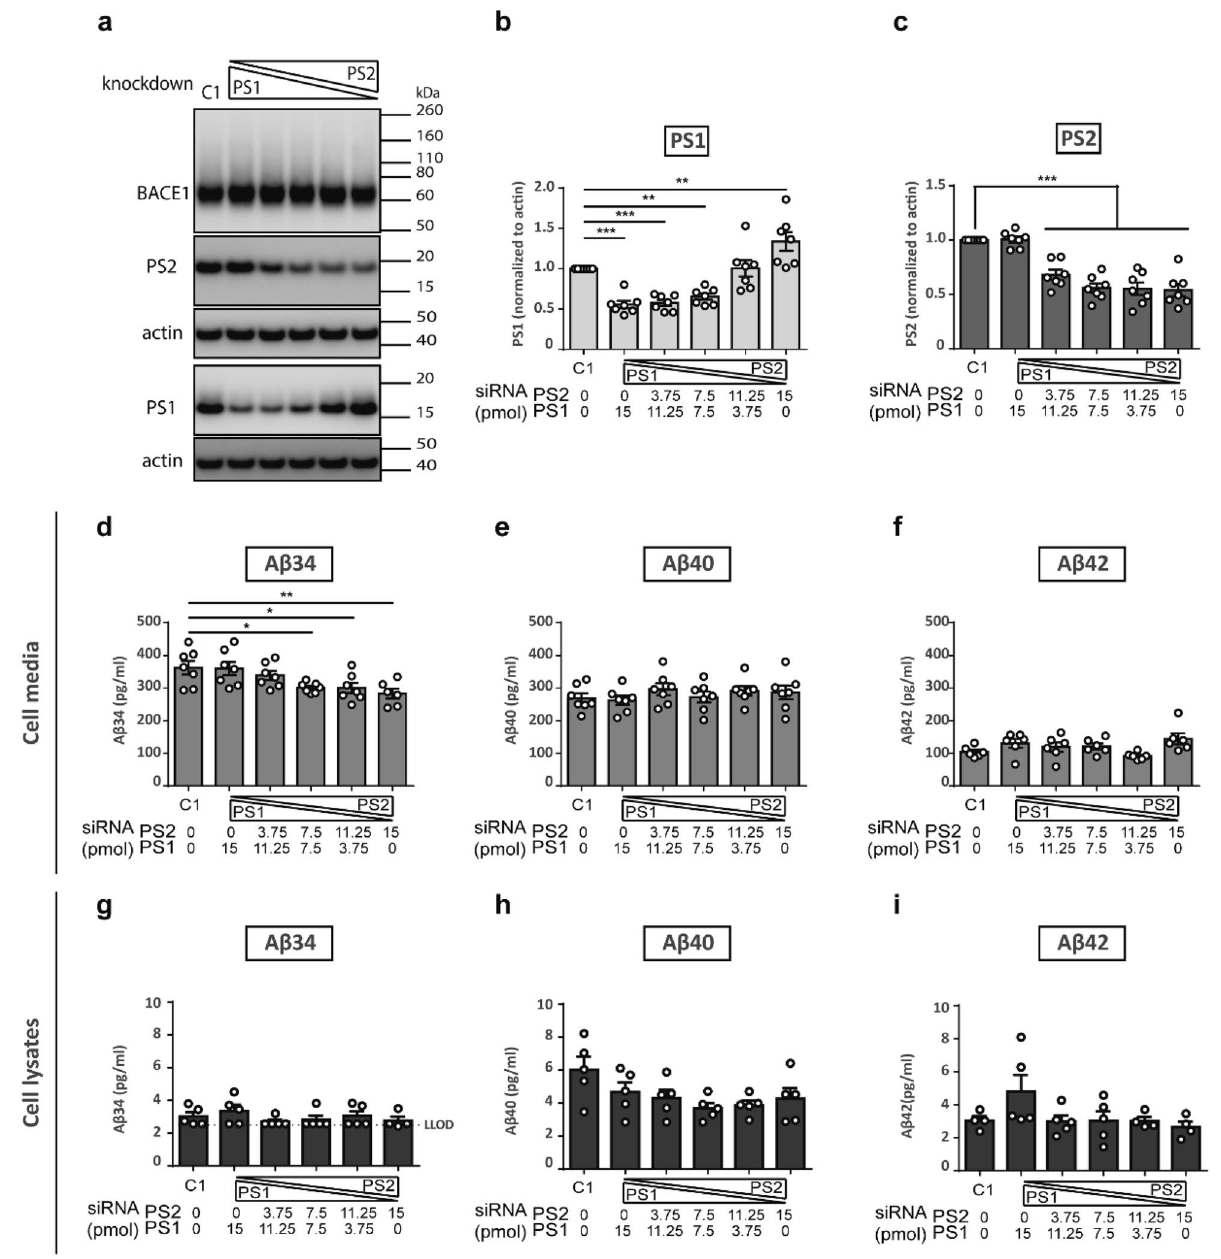
Figure 5. PS2 but not PS1 knockdown reduced Aβ34 levels from BACE1 overexpressing cells. Expression of PS1 and PS2 and Aβ levels were analyzed by Western blot, ELISA and MSD assays, respectively. Representative Western blots from 7 independent experiments for combinatorial PS1 and PS2 knockdown in SH-SY5Y BACE1 overexpressing cells ( a ). Uncropped blots are included in a Supplementary Information file. Quantification of relative amounts of PS1 ( b ) and of PS2 ( c ), and absolute amounts of Aβ34 ( d ), Aβ40 ( e ), and Aβ42 ( f ) in cell media by ELISA and Aβ34 ( g ), Aβ40 ( h ), and Aβ42 ( i ) in cell lysates by MSD. Bars and error bars indicate mean ± s.e.m. Dunnett’s post-hoc tests were performed for pairwise comparisons; selected comparisons are highlighted ***p < 0.001, **p < 0.01, *p < 0.05. ( b ) PS1, 1-WAY ANOVA, F(5,36) = 20.06, p < 0.0001, ( c ) PS2, 1-WAY ANOVA, F(5,36) = 26.37, p < 0.0001, ( d ) Aβ34, 1-WAY ANOVA, F(5,35) = 4.268, p < 0.005, ( e ) Aβ40, 1-WAY ANOVA, F(5,36) = 0.6677, p = 0.6504, ( f ) Aβ42, 1-WAY ANOVA, F(5,36) = 2.502, p = 0.0523, ( g ) Aβ34, 1-WAY ANOVA, F(5,23) = 0.8428, p = 0.5334, ( h ) Aβ40, 1-WAY ANOVA, F(5,24) = 2.276, p = 0.0791, ( i ) Aβ42, 1-WAY ANOVA, F(5,21) = 1.869, p =